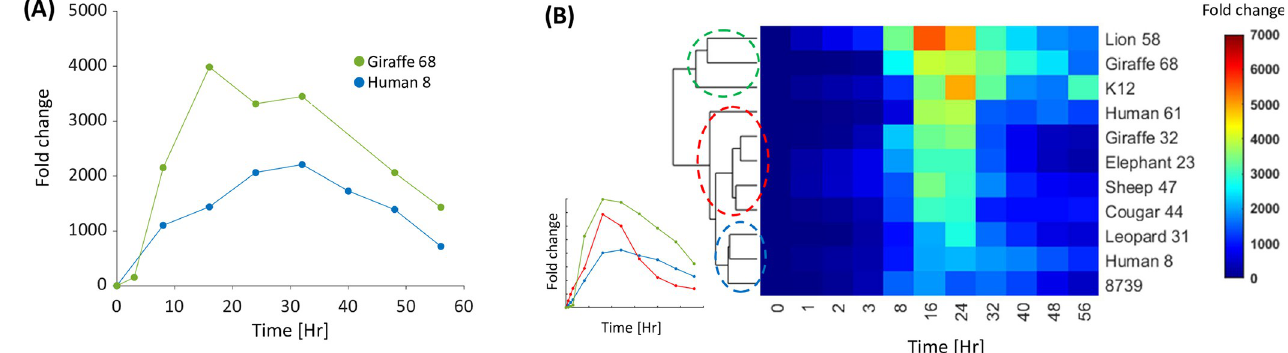
Fig 1. E . coli strains show significant variability in their growth and death dynamics. (A) Two representative growth curves of two samples from different natural strains. The dots represent the bacteria live count in a specific time point normalized by the starting point. (B) Hierarchical clustering of the median growth curves of 11 E . Coli strains isolated from various environments. The analysis reveals three groups that exhibit different dynamics patterns. The analyzed time series vectors are the median trajectories of 3 to 7 replicates for each time point. The inset depicts the growth trajectory of a representative replicate from each